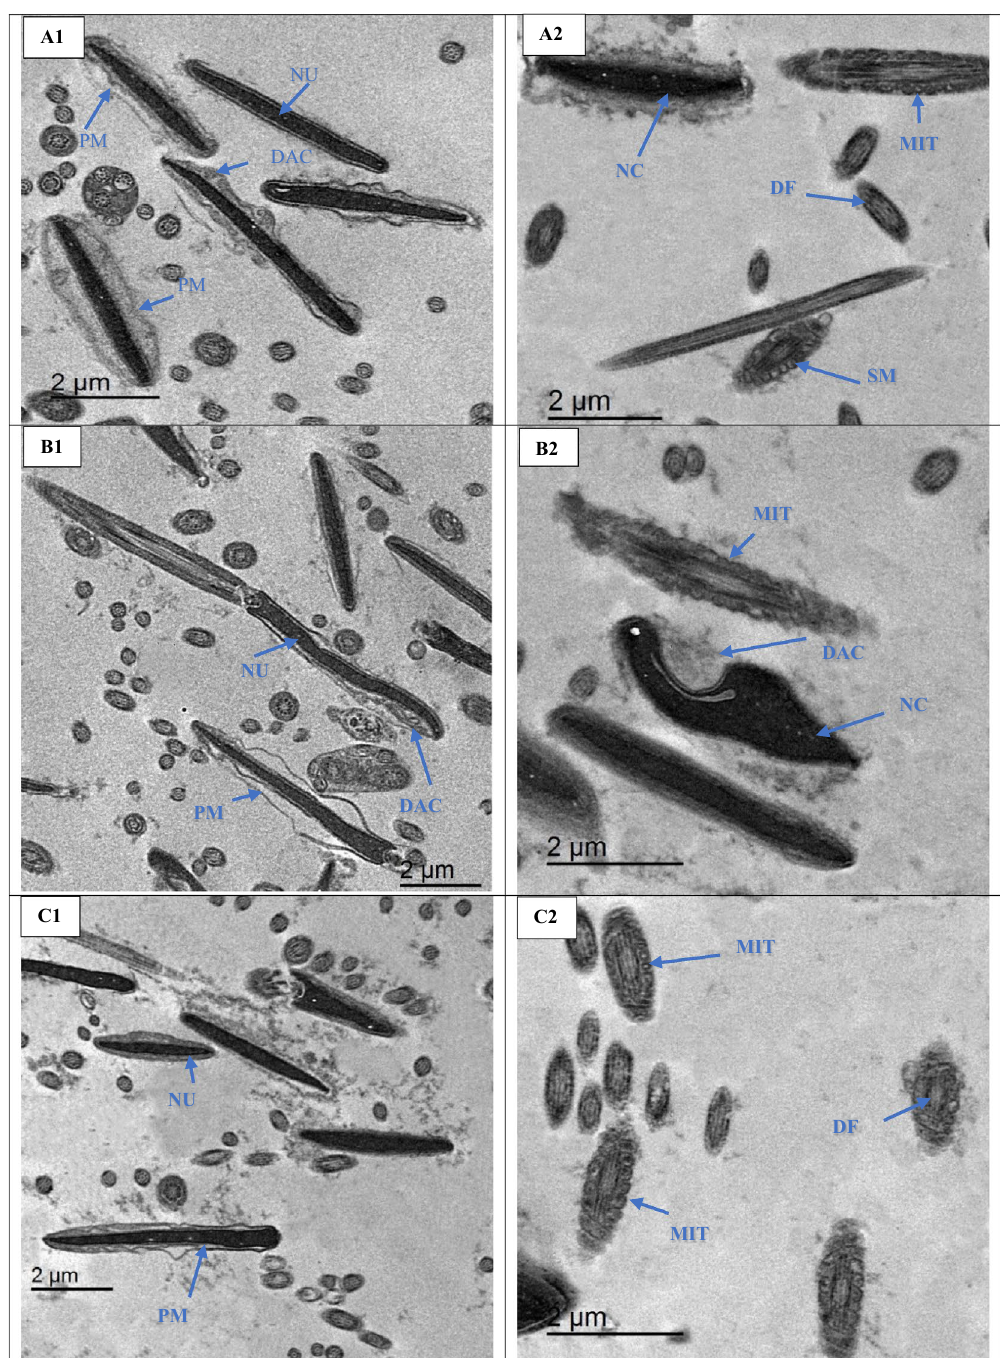
Figure 4. Transmission electron microscopy (TEM) micrographs of post–thawed sperm of buffalo in groups treated with 0, 25, 50, 75 or 150 µg/mL alpha-lipoic acid loaded liposomes (ALAN) (A1,2; B1,2; C1,2; D1,2 and E1,2 respectively). A1, A2) The control group (A1 for sperm head and A2 for sperm tail) showing nucleus (NU) without plasma membrane (PM), swollen plasma membrane, damaged acrosomal (DAC), necrotic chromatin (NC) and mitochondria (MIT) with distorted cristae. B1, B2, C1 and C2) The groups 25 and 50 µg ALAN supplemented with freezing extender, buffalo head sperm has moderate condensed chromatin, acrosomal swelling and some alterations in plasma integrities. Moreover, the same groups showing slight abnormal mitochondrial (MIT). D1, D2, E1 and E2) The groups 75 and 150 µg ALAN supplemented with freezing extender, buffalo sperm showing preserve plasma membrane structure (PM), condensed chromatin (CC), and regular flagellum (RF) with sustain of cristae membrane in MIT. CC; condensed chromatin, SM; swollen mitochondria, NC; necrotic chromatin, PM; plasma membrane, MIT; mitochondria, AC; intact acrosomal, DAC; Damaged acrosomal, DF; Disarranged of flagellum, RF; Regular